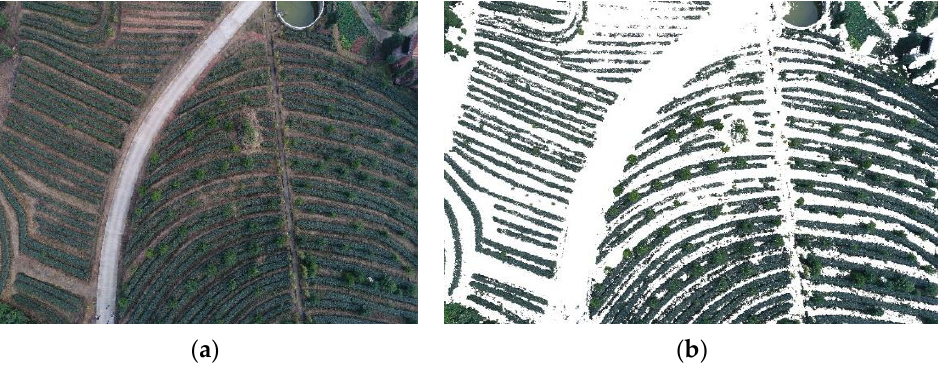
Figure 11. Original image ( a ) and the image with RGRI features ( b ).